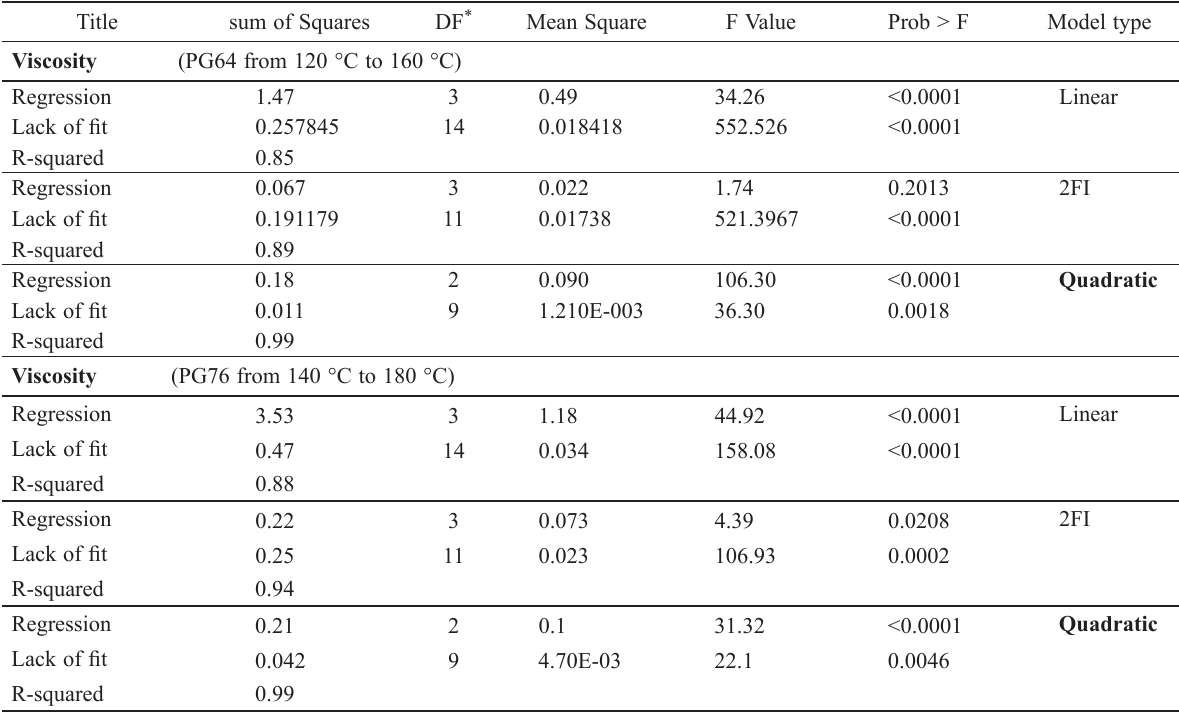
Table 6. Regression models for prediction of viscosity of